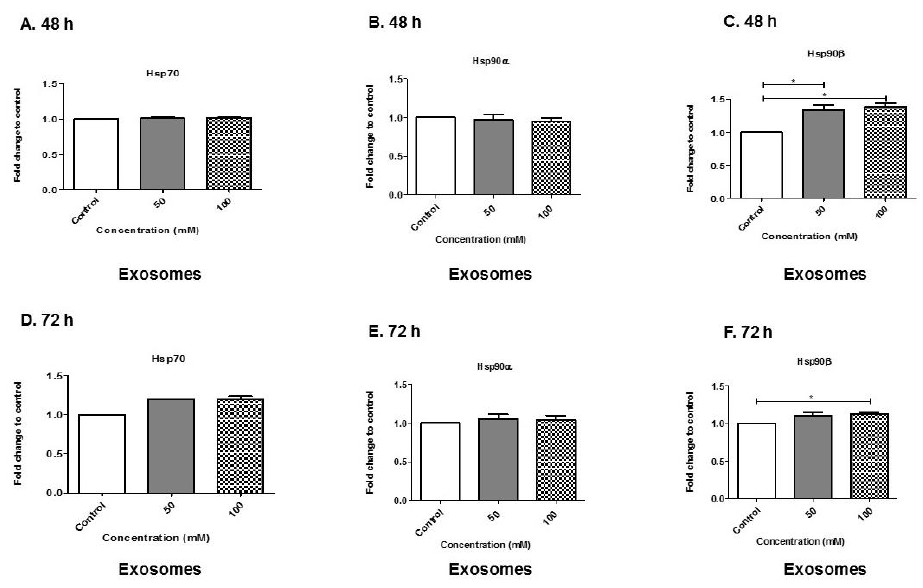
Figure 7. Production of heat shock proteins within BV-2-derived exosomes. ( A , D ) Hsp70, ( B , E ) Hsp90 α and ( C , F ) Hsp90 β were expressed in exosomes after EtOH dosing at 48 or 72 h using ELISA. Experiments involving ELISA were performed with four to six independent replicates. Data are presented as mean ± SEM. Significant differences were determined using one-way ANOVA with post hoc Tukey’s analysis. Significance is defined as (*) p ≤ 0.05.